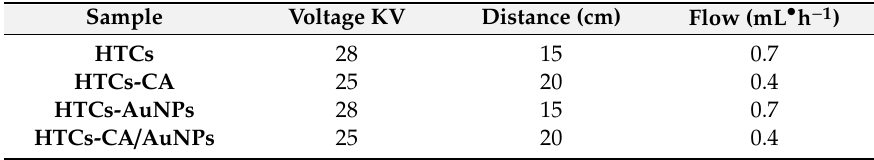
Table 1. Electrospinning parameters used to produce the electrospun